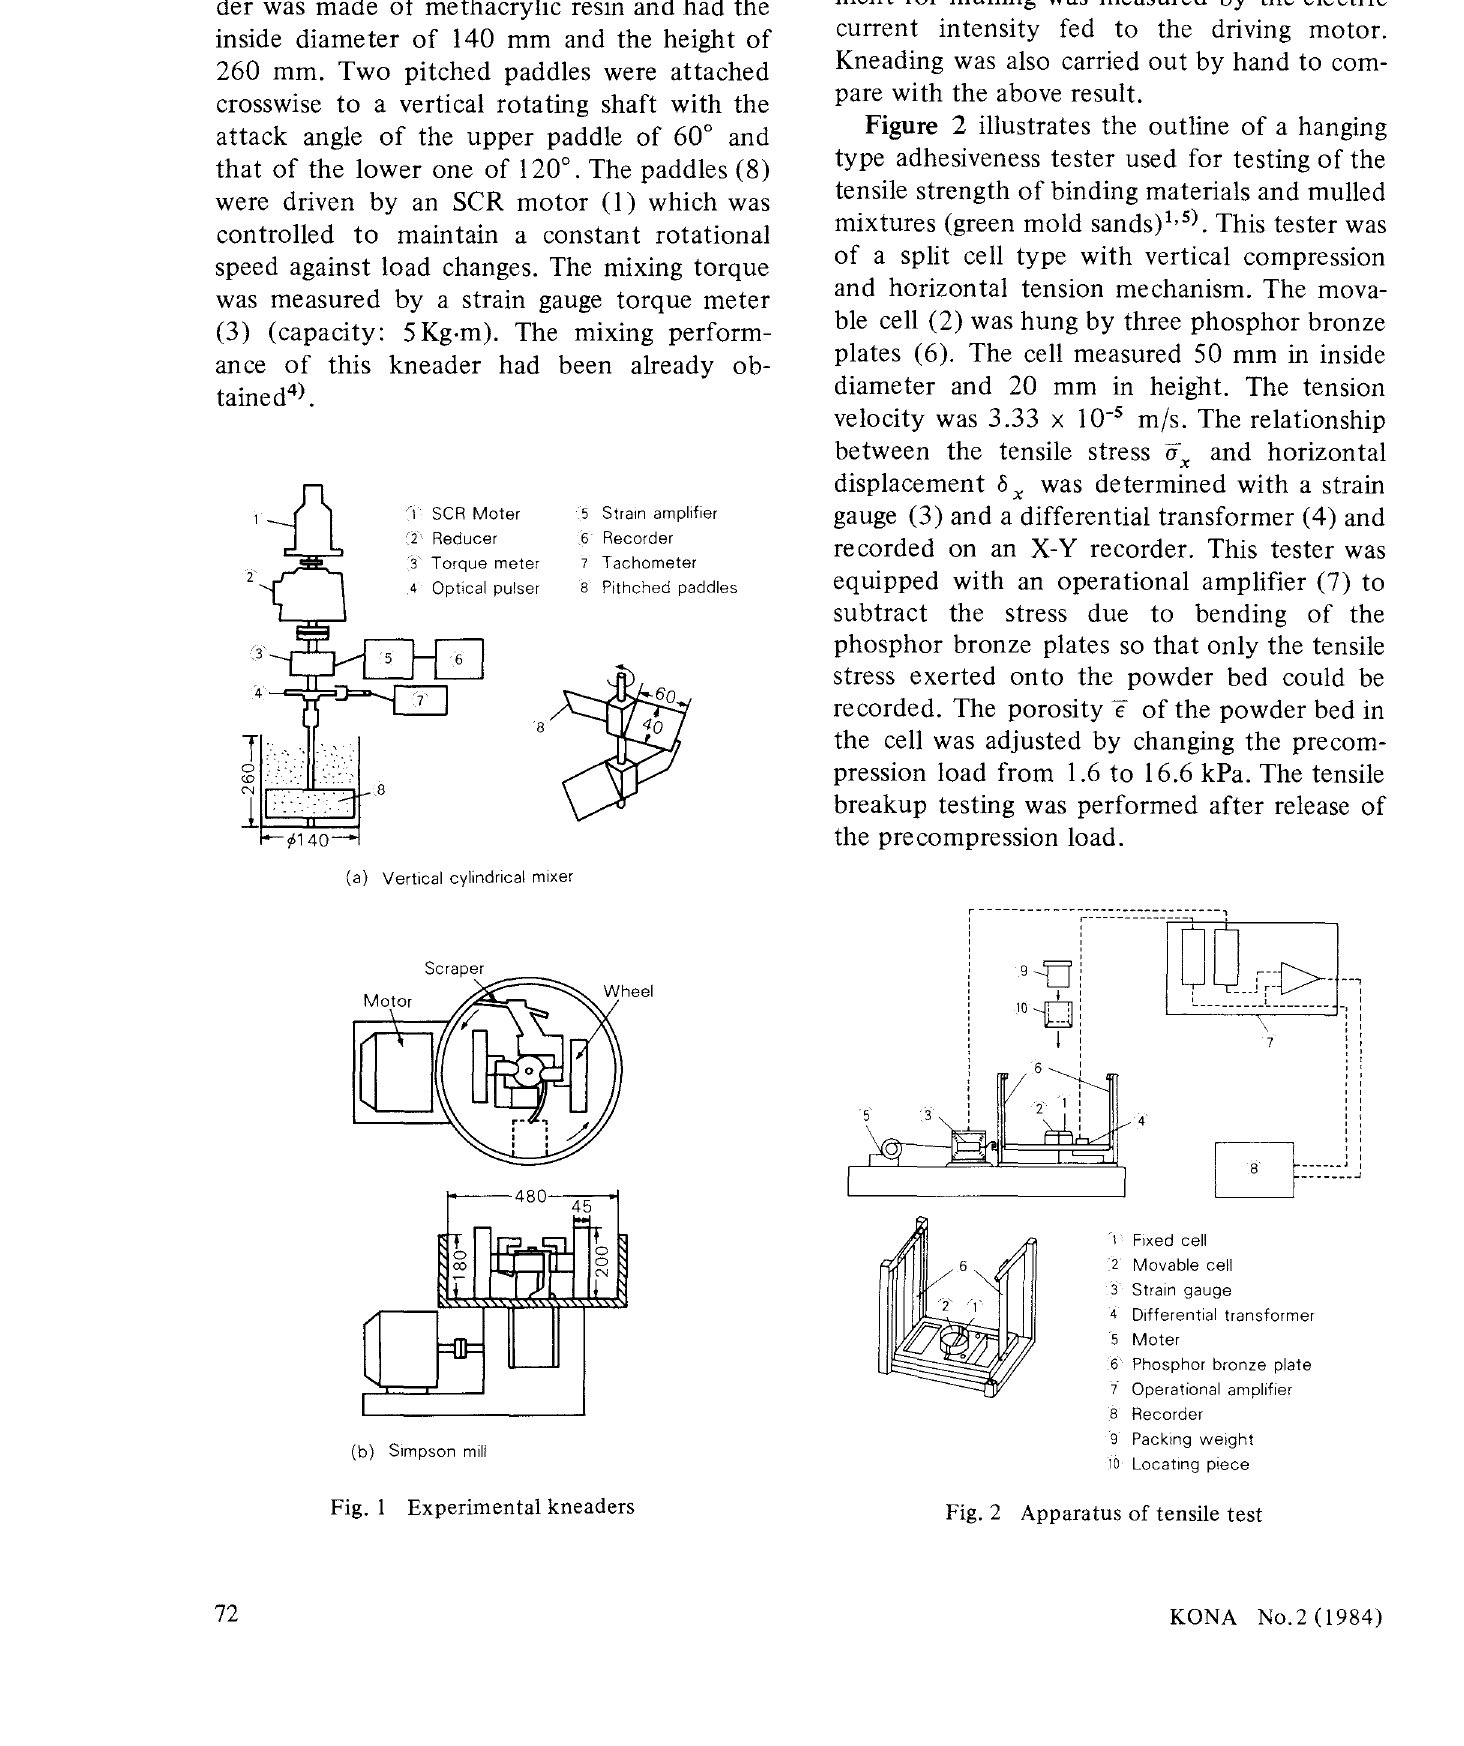
Fig. 2 Apparatus of tensile